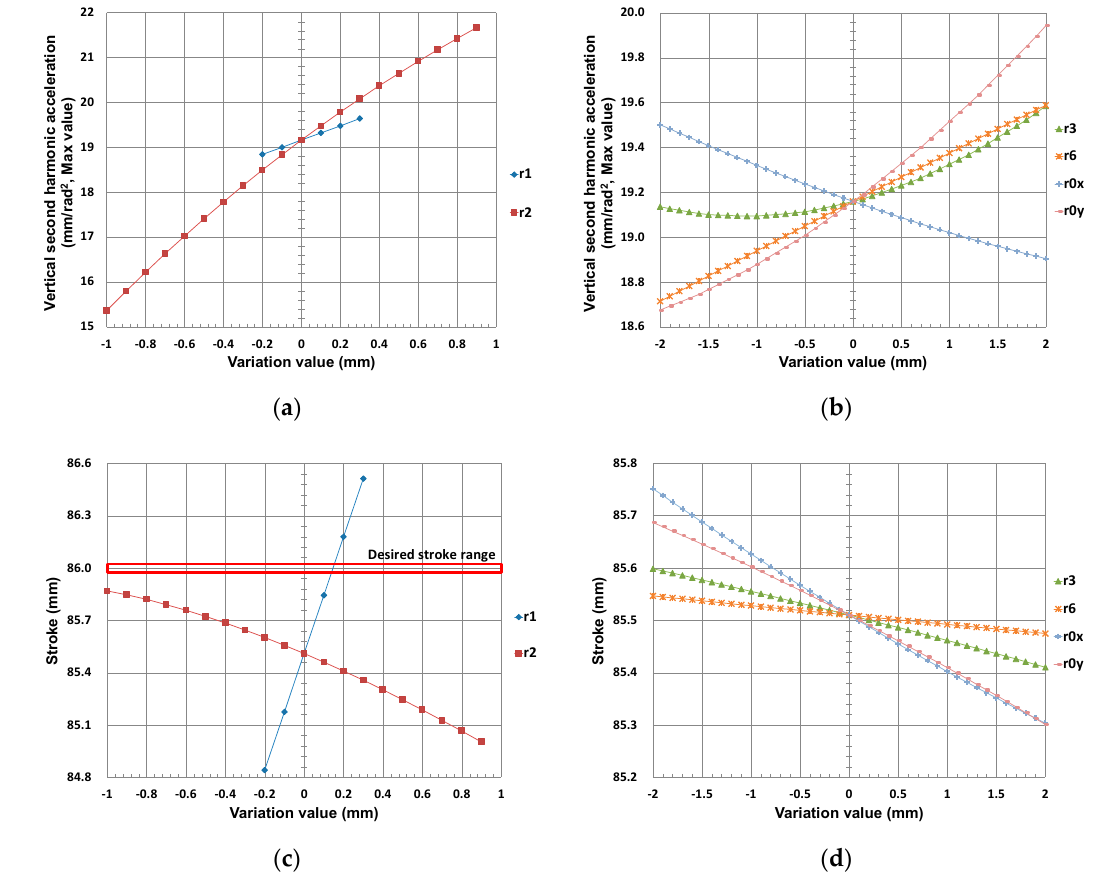
Figure 8. With the minimum length of r 4 and the maximum r 5 , influence on the maximum of vertical second harmonic acceleration sum of length change in: ( a ) r 1 and r 2 and ( b ) r 3 , r 6 , r 0 x , and r 0 y ; influence on the stroke of length change in: ( c ) r 1 and r 2 and ( d ) r 3 , r 6 , r 0 x , and r 0 y in the in-line four-cylinder engine. Table 6. Link length variation cases for Step